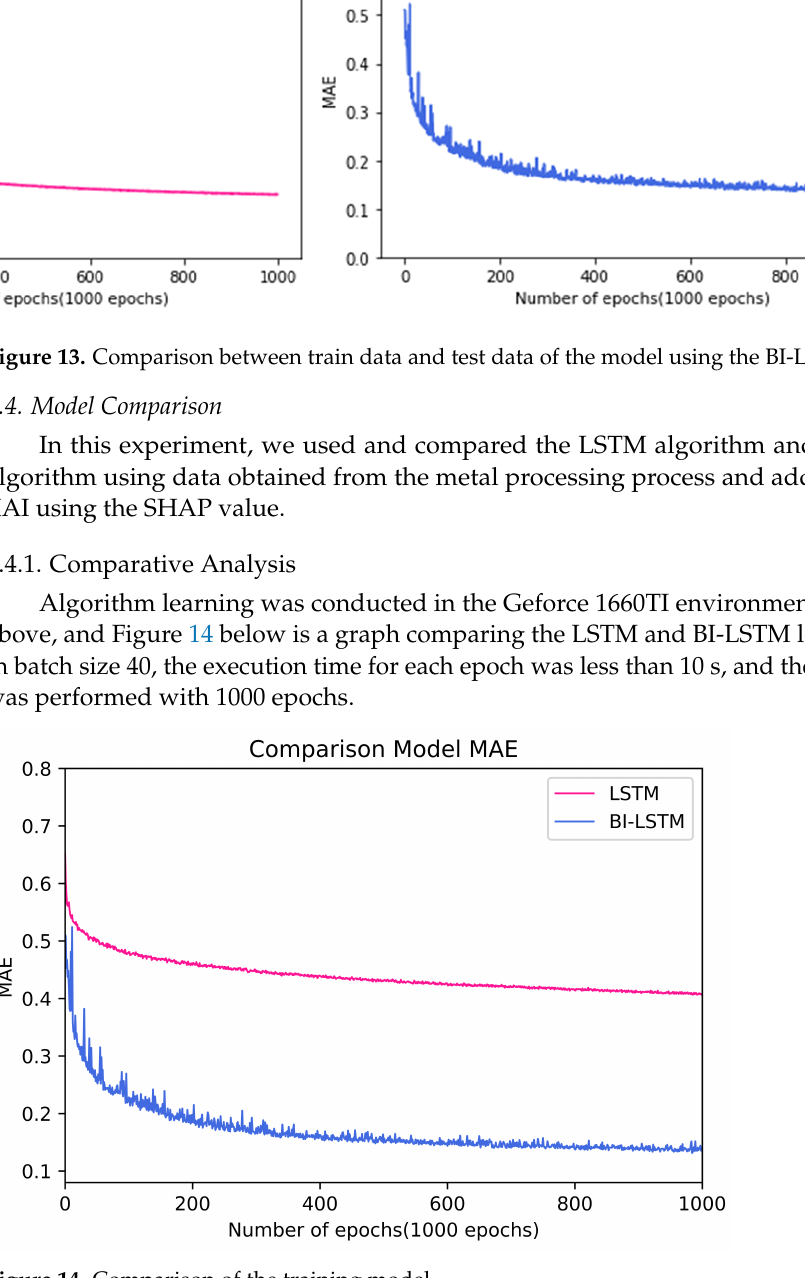
Figure 14. Comparison of the training